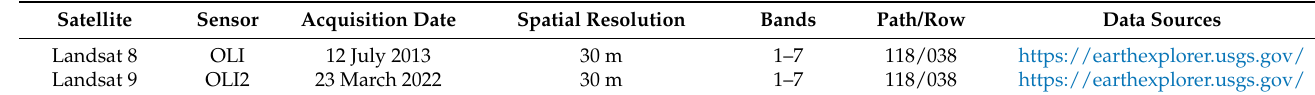
Table 1. Datasets used in the